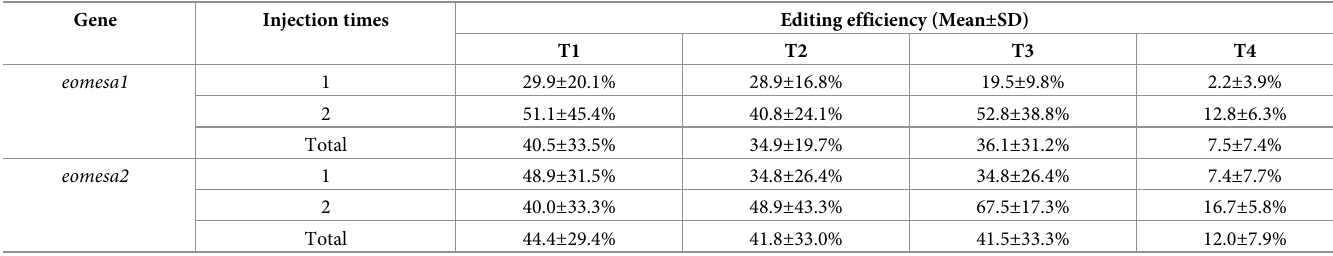
Table 2. The statistics of the knockout efficiency on embryos at 24 hpf.